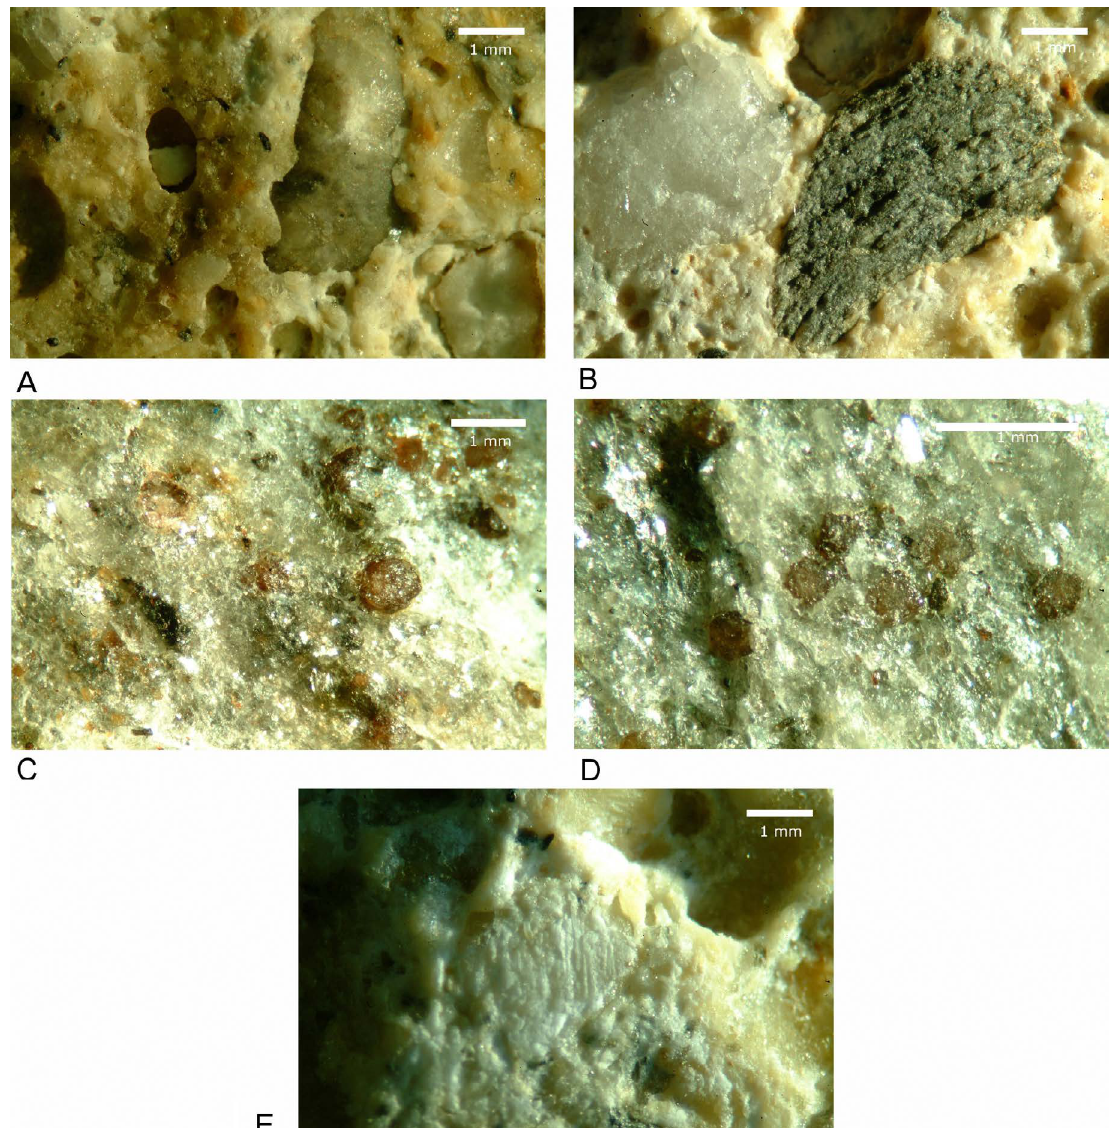
Figure 4. (a) Conglomerate grinding slab used for grinding barley during 30 minutes with a wooden rubber: a micro-fracture can be seen which affects the tip of a quartz grain; (b) Conglomerate grinding slab used for grinding barley during 30 minutes with a metapsammite rubber: levelled mineral grains dominate; (c) Garnet bearing mica-schist grinding slab used for grinding barley during 60 minutes with a wooden rubber: rounded garnet and sinuous topography; (d) Garnet bearing mica-schist grinding slab used for grinding barley during 60 minutes with a metapsammite rubber: garnets and micaceous matrix are worn to the same level, an unaltered garnet appears in low topography; (e) Conglomerate grinding slab used for grinding barley during 60 minutes with a metapsammite rubber: parallel micro-striations on mineral